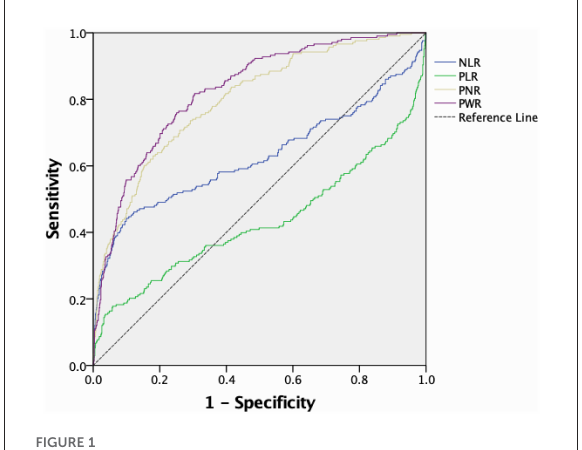
FIGURE1 ROC curve and corresponding AUC of peripheral blood cell ratios predicting IA rupture. ROC, Receiver operating characteristic; AUC, area under the curve; IA, intracranial aneurysm.